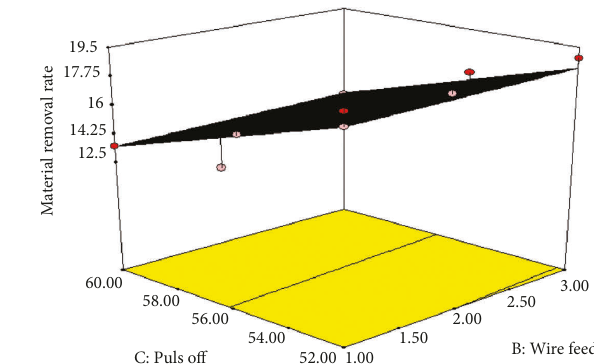
Figure 12: Effect on WF and PT